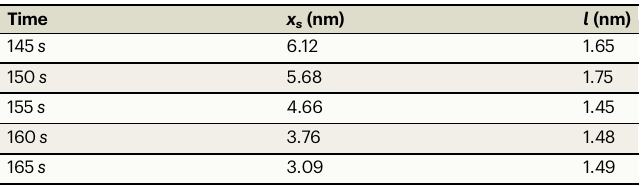
Table1 | Fitting parameters ofthe intensitycurves for different times using Fick ’ s law Time x s (nm) l